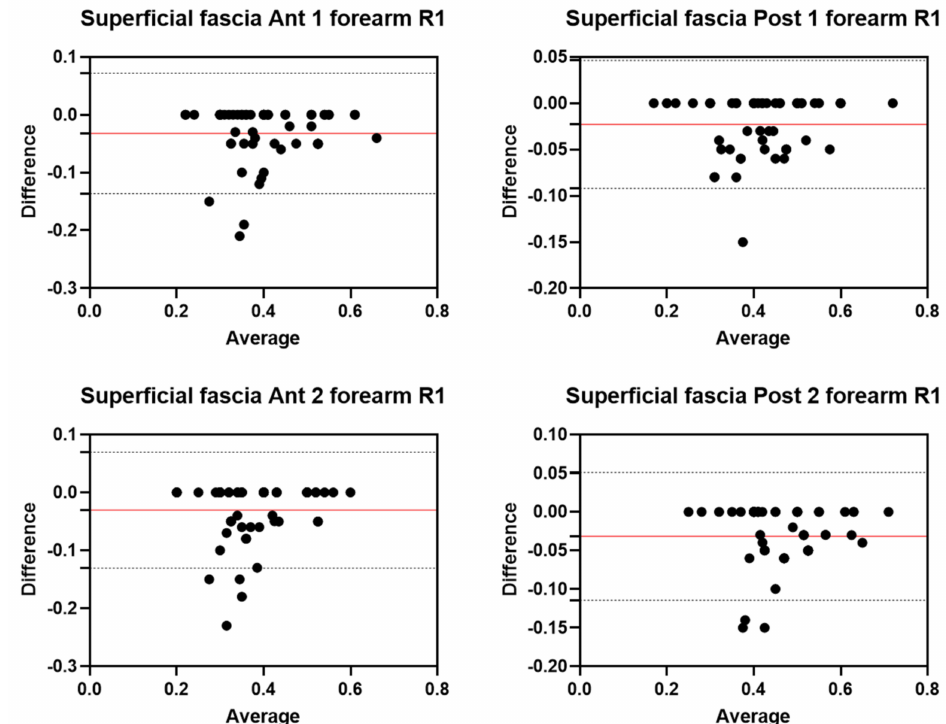
Figure 9. Bland–Altman plot comparing two sessions of Rater 1 (R1) measuring the US thickness of the superficial fascia of the forearm for the different levels. Red line = bias or mean difference; dashed lines: 95% limits of agreement (LoAs).